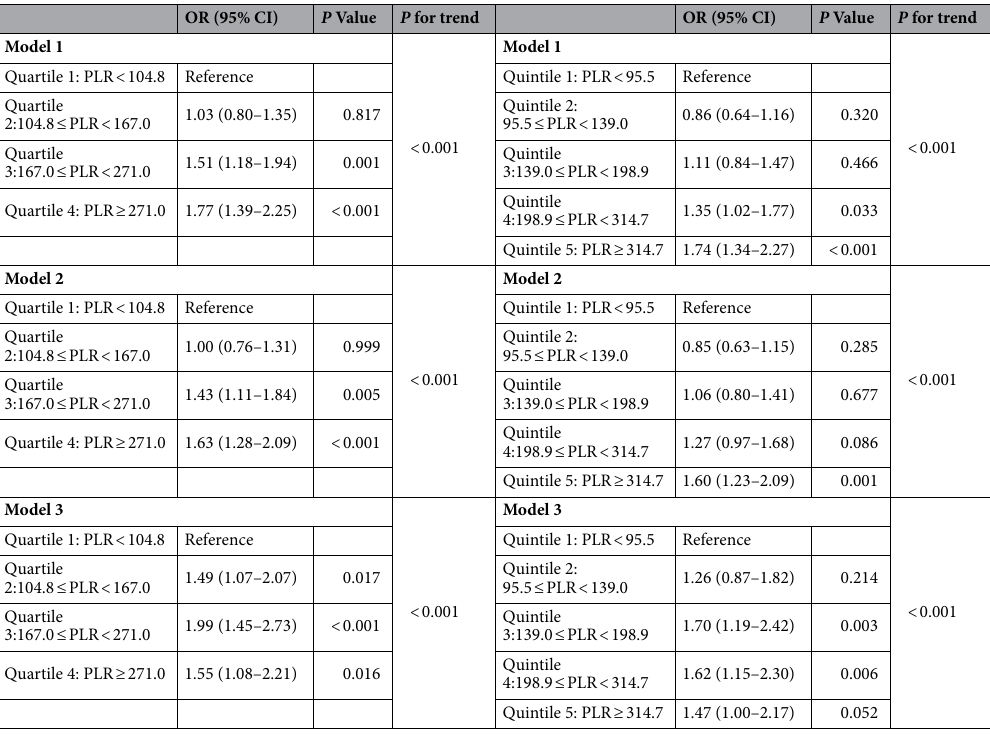
Table 3. The association between PLR and in-hospital mortality. Models were derived from binary logistic regression analysis. P for trend was calculated using binary logistic analysis to determine whether there was a trend when PLR was included as a grouping variable in the model (Quartile 1–4 or Quintile1-5). When PLR was included as a grouping variable in the model, P values were calculated using binary logistic analysis to determine whether there was a relationship between PLR quartiles (quintiles) and in-hospital mortality with Quartile1 (Quintile 1) serving as the reference group. When PLR was included as a continuous variable in the model, P values were calculated using binary logistic analysis to determine whether there was a relationship between PLR and in-hospital mortality. Model 1: unadjusted. Model 2: adjusted for age, gender, ethnicity. Model 3: adjusted for age, gender, ethnicity, systolic blood pressure, diastolic blood pressure, mean blood pressure, heart rate, body mass index, respiration, coronary artery disease, acute coronary syndrome, congestive heart failure, NSTEMI, cardiac arrest, arrhythmias, atrial fibrillation, ventricular arrhythmias, atrioventricular block, respiratory failure, stroke, malignancy, cardiomyopathy, hypertension, diabetes, white blood cell, red blood cell, hematocrit, blood nitrogen urea, creatinine, sodium, potassium, oral anticoagulants, ACEI/ARB, beta-blockers, statin, transfusion, NLR, APS and APACHE IV. PLR platelet-lymphocyte ratio, NLR neutrophil–lymphocyte ratio, OR odds ratio, CI confidence interval.